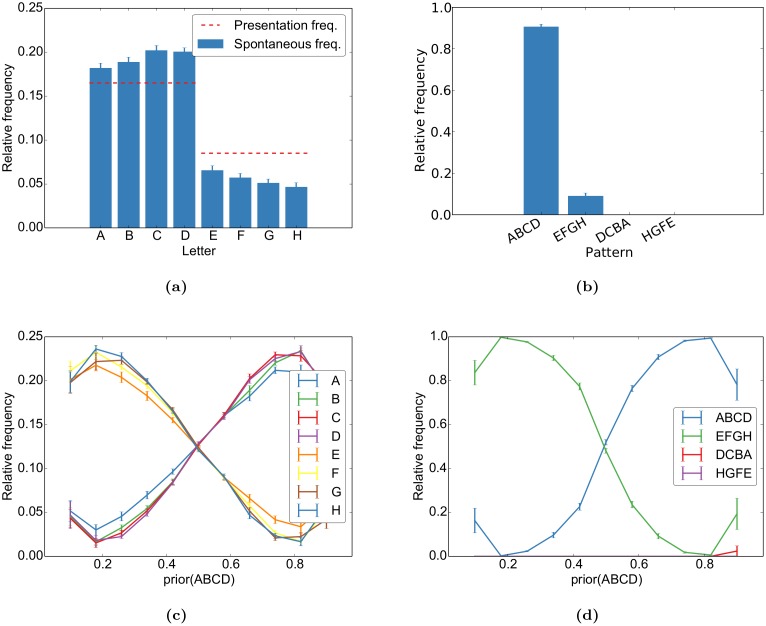
Different priors are learnt by the network.During self-organization, the sequences “ABCD” and “EFGH” were randomly interleaved with frequencies of 67% and 33%, respectively. This is reflected in the relative occurrence of (a) each letter and (b) each word in the spontaneous activity. For different priors during self-organization, this results in the frequencies in (c) for each letter and in (d) for each word. Both show overlearning effects in that their frequencies are biased in favour of the word that was shown more often. The reversing trend and high variance for the extreme priors (0.1 and 0.9) can be accounted for by pathological network dynamics for some simulations with these priors. The letter frequency is the observed frequency in the evoked activity while the word frequency was normalized over the total number of observed words (“ABCD”, “EFGH”, “DCBA”, and “HGFE”) to yield better comparison over different realizations. Error bars represent SEM over 20 independent realizations.